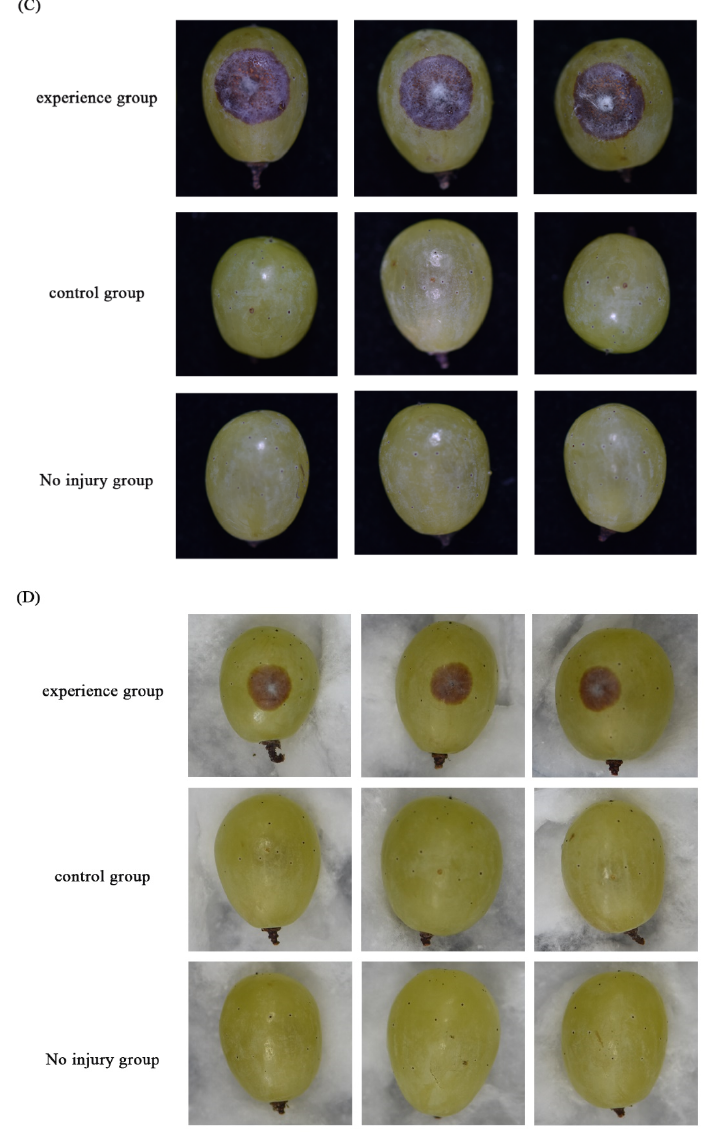
Figure 4. Pathogenicity of the transformants on grape leaves and fruits. ( A ) The grape leaves were inoculated with mycelial blocks and the symptoms were checked after 3 days and seven days ( B ); ( C ) Grape fruits were inoculated with spore suspension and checked after 3 days and 6 days ( D